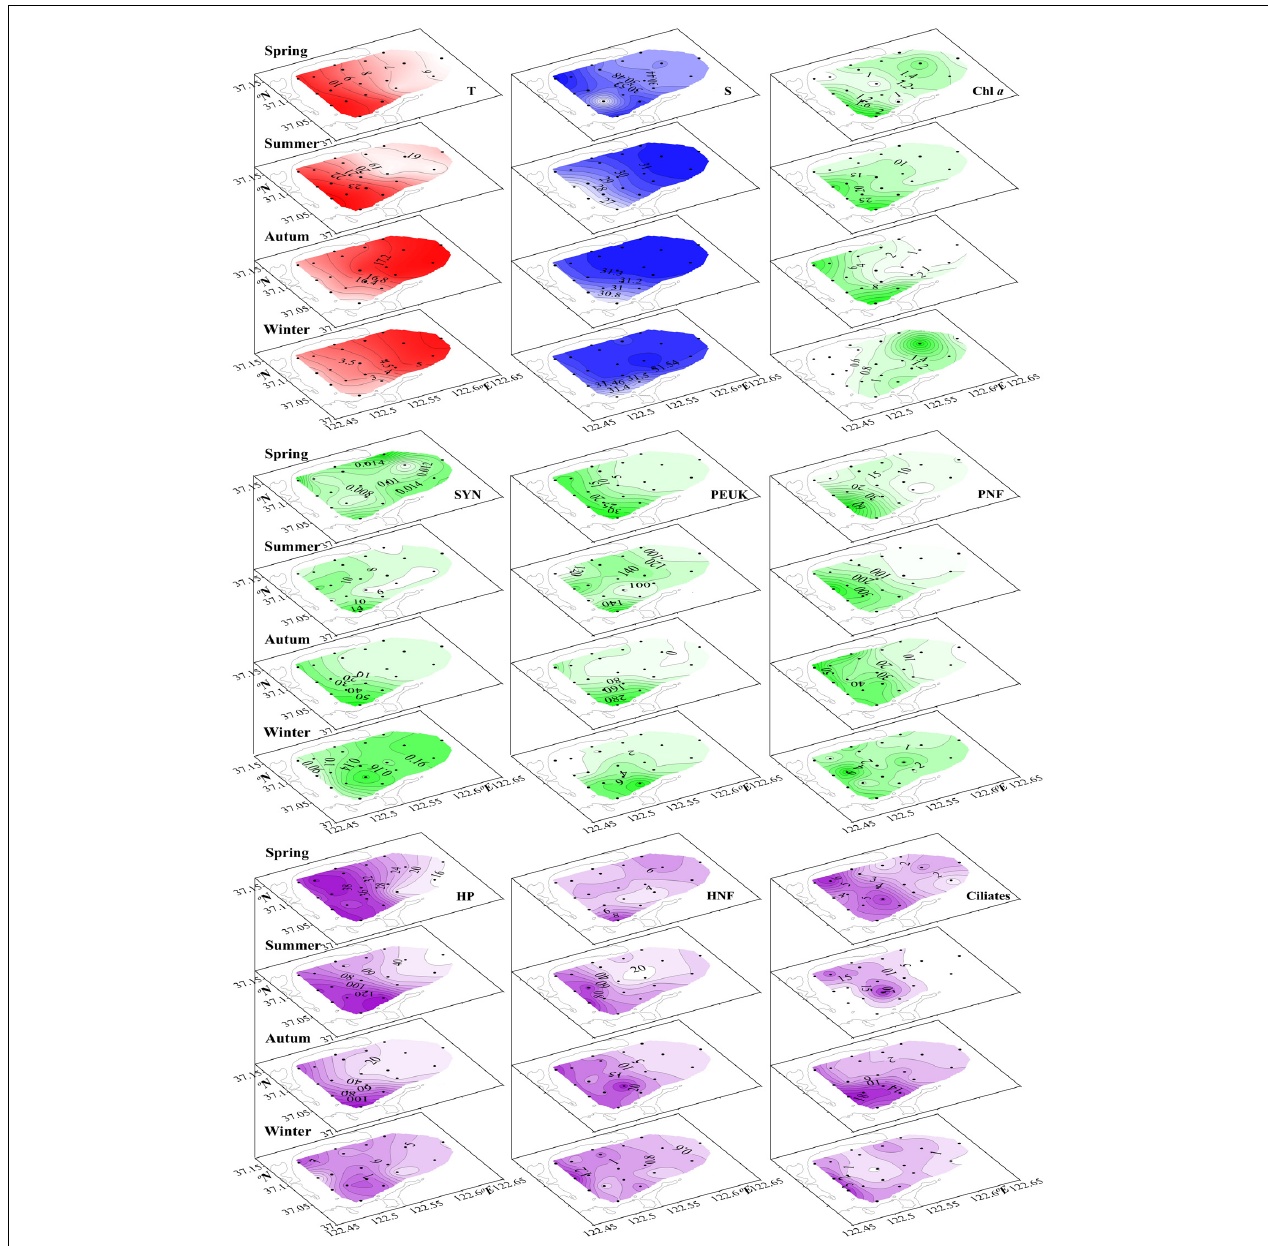
FIGURE 2 | Seasonal surface distribution of temperature (T, ◦ C), salinity (S), Chlorophyll a concentration (Chl a , µ g dm − 3 ), and microbial food wed component biomasses ( µ g C dm − 3 ) through four successive seasons, spring to winter. SYN, Synechococcus ; PEUK, phototrophic picoeukaryotes; PNF, pigmented nanoflagellates; HP, heterotrophic prokaryotes; HNF, heterotrophic nanoflagellates.